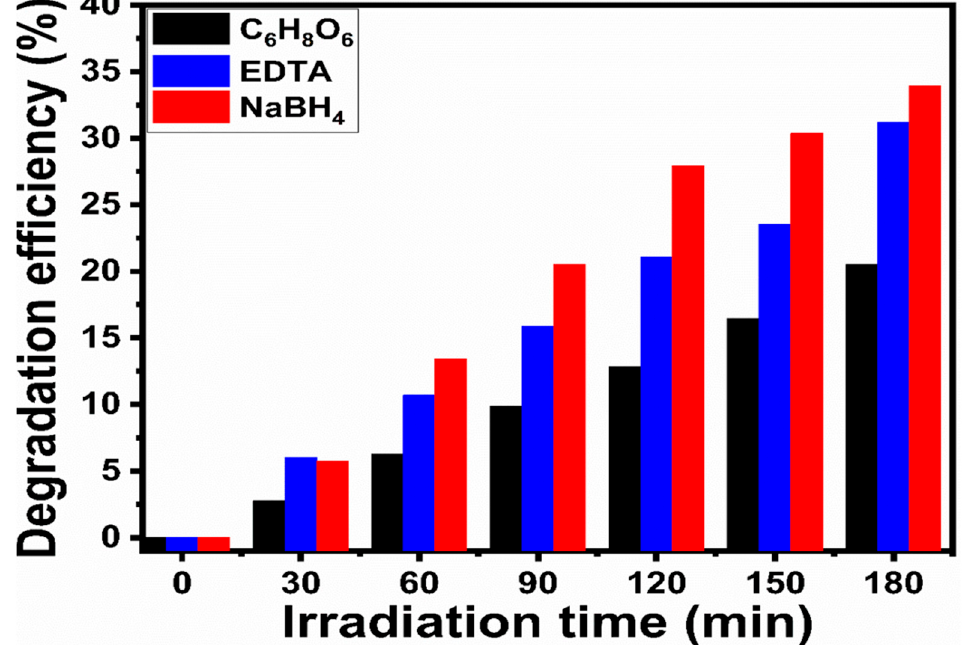
Figure 10. The scavenger study for the identification of driving radicals towards degradation of MB under the illumination of UV light in aqueous solution.